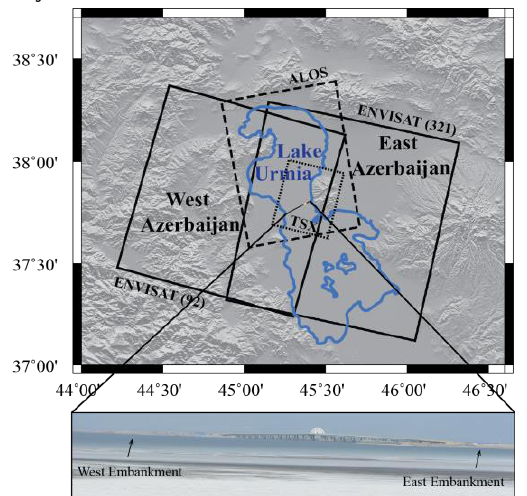
covering December 2006-July 2010, and 18 TSX in a descending track covering May 2012-January 2013. Figure 1 illustrates the outline SAR frames from satellites used in this study.